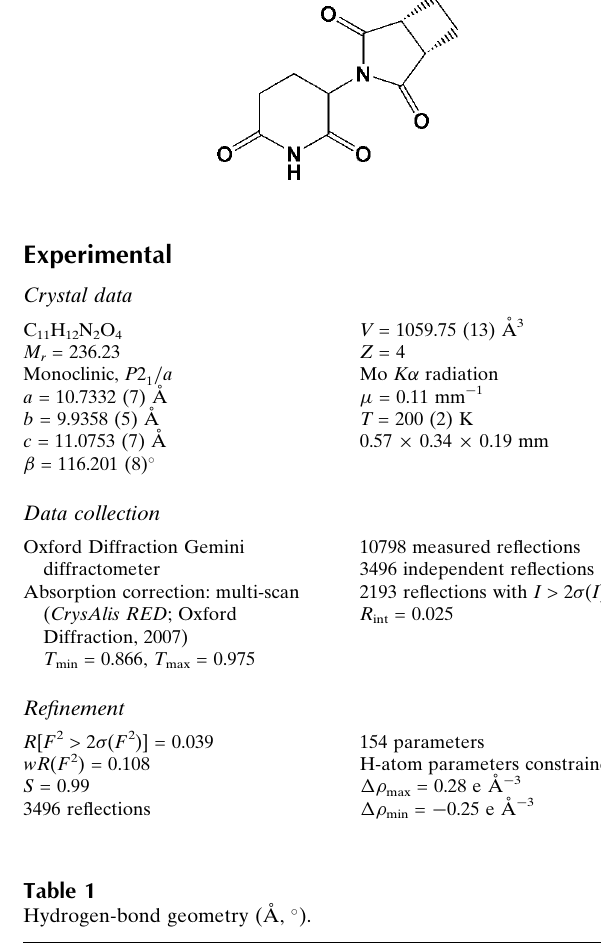
Hydrogen-bond geometry (A˚ , (cid:1)